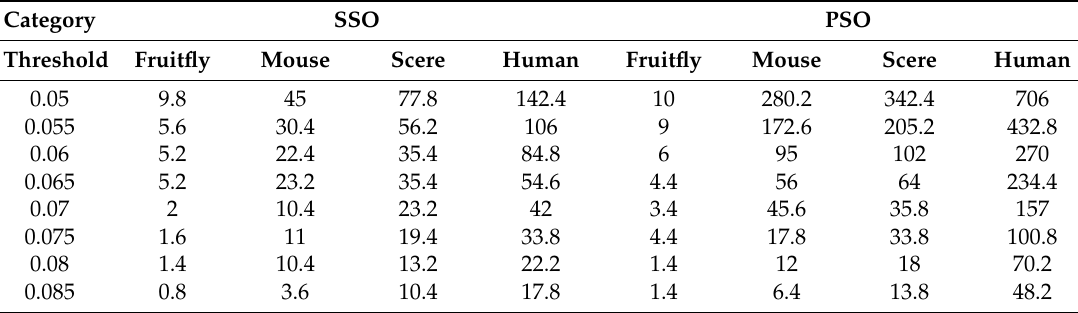
Table 6. Filtered protein number for PSO and SSO algorithm.